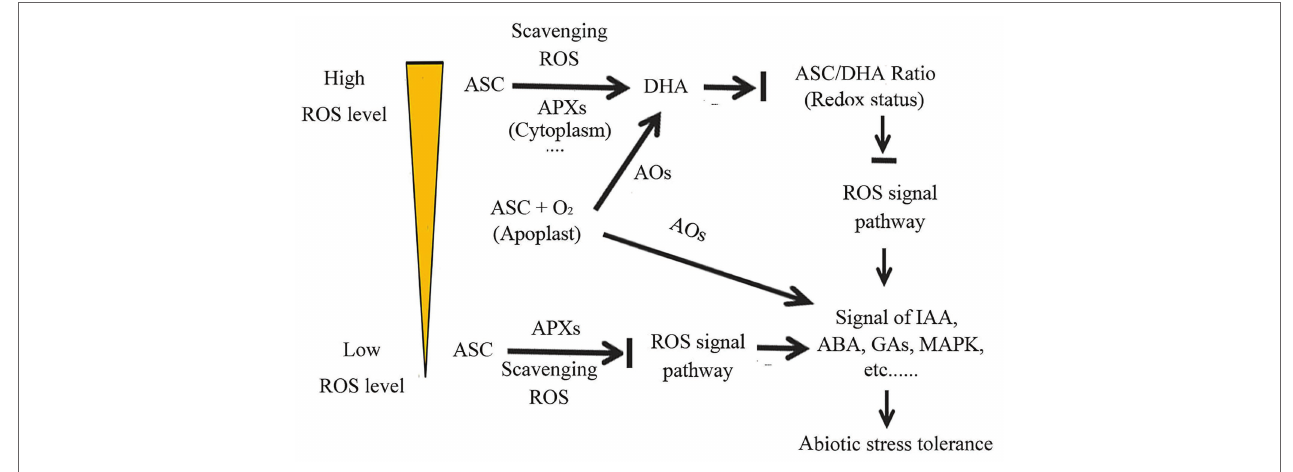
FIGURE 3 | Ascorbate regulates the cellular redox state, thereby coordinating various signaling pathways, to enhance plant adaptability to abiotic